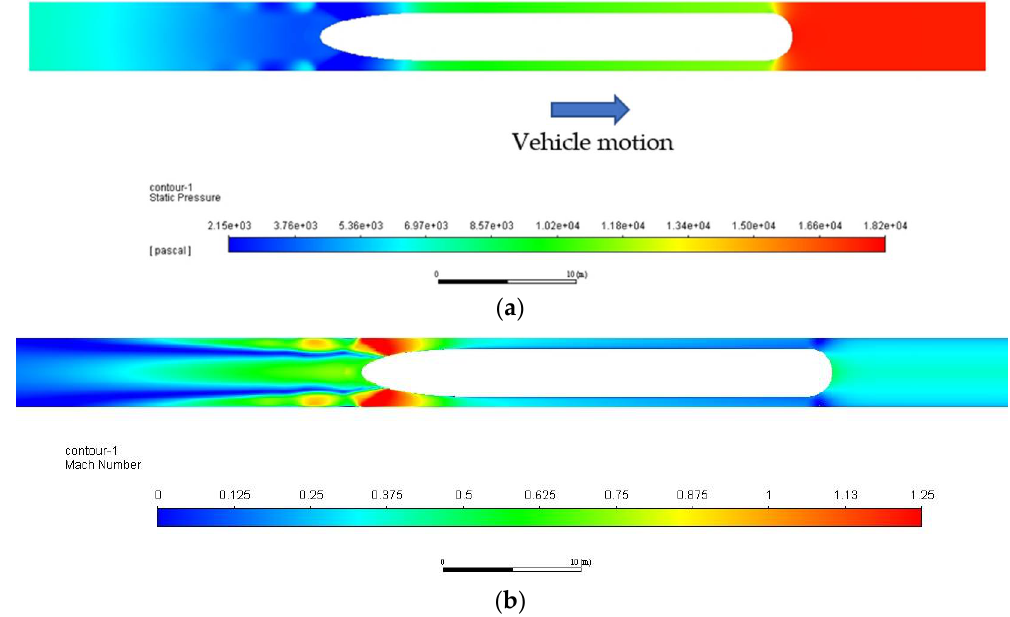
Figure 10. ( a ) Static pressure; ( b ) Mach Number contour, t = 6.33 s (M = 0.6, β = 0.56). Figure 10a indicates the static pressure contour around the vehicle. The pressure is exceptionally high downstream (red colormap) and expanded into the left. The calculations performed by MOC show a value of 23 KN. Figure 10b reveals the high Mach